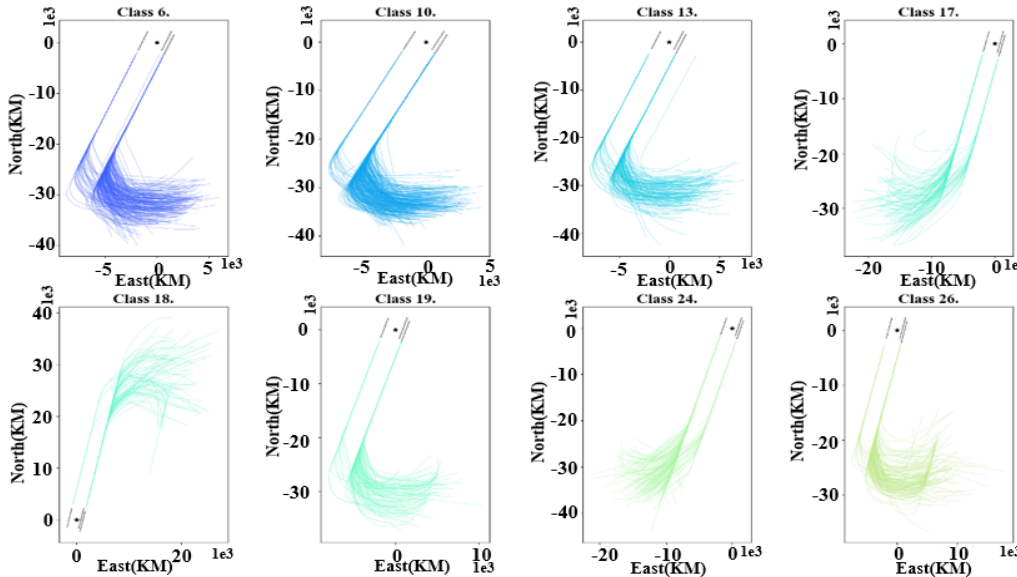
Figure 10. Visualize the clustering results of each class of arrival trajectories.